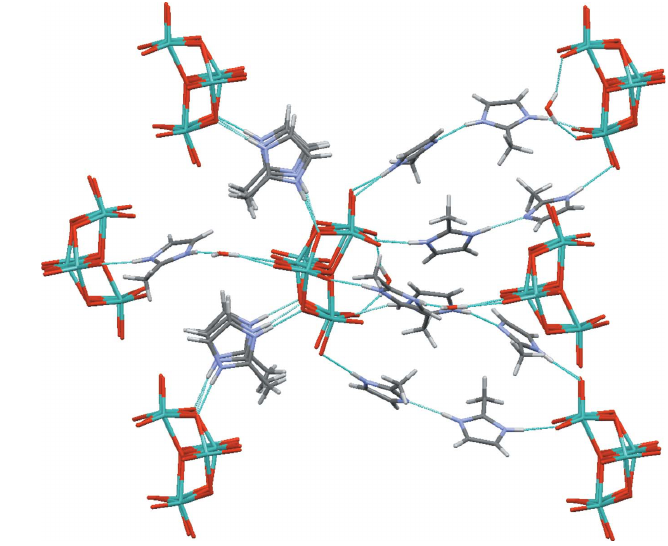
Figure 1 Molecular structure of the [Mo 7 O 24 ] 6 (cid:3) heptamolybdate cluster anion in